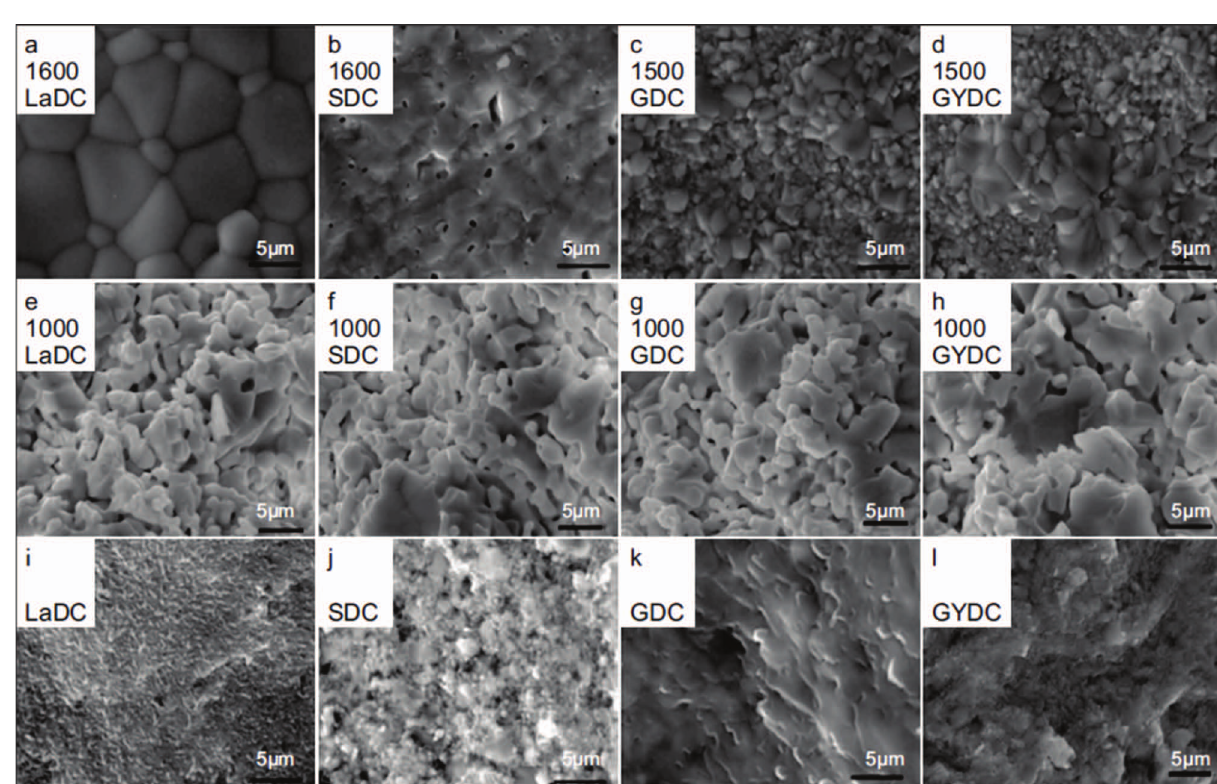
Fig. 7. RDC sintered at 1500 – 1600 (cid:1) C for 5 h; sintered at 1000 (cid:1) C for 10 h; SEM diagram of carbonate composite magni fi ed 5000 times. (Here, (a), (e), (i) have R = La; (b), (f), (j) have R = Sm; (c), (g), (k) have R = Gd; (d), (h), (l) have R = Gd + Y.)